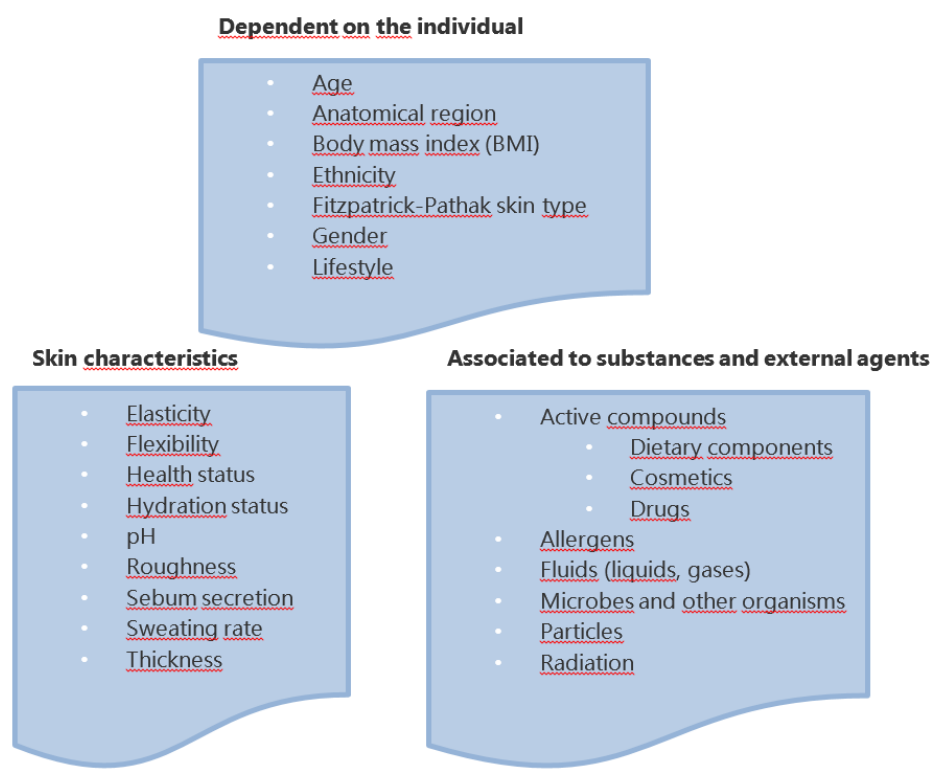
Figure 2. Factors affecting skin properties. Adapted from D ą browska et al. [4]. Figure 2. Factors a ff ecting skin properties. Adapted from D ˛abrowska et al.